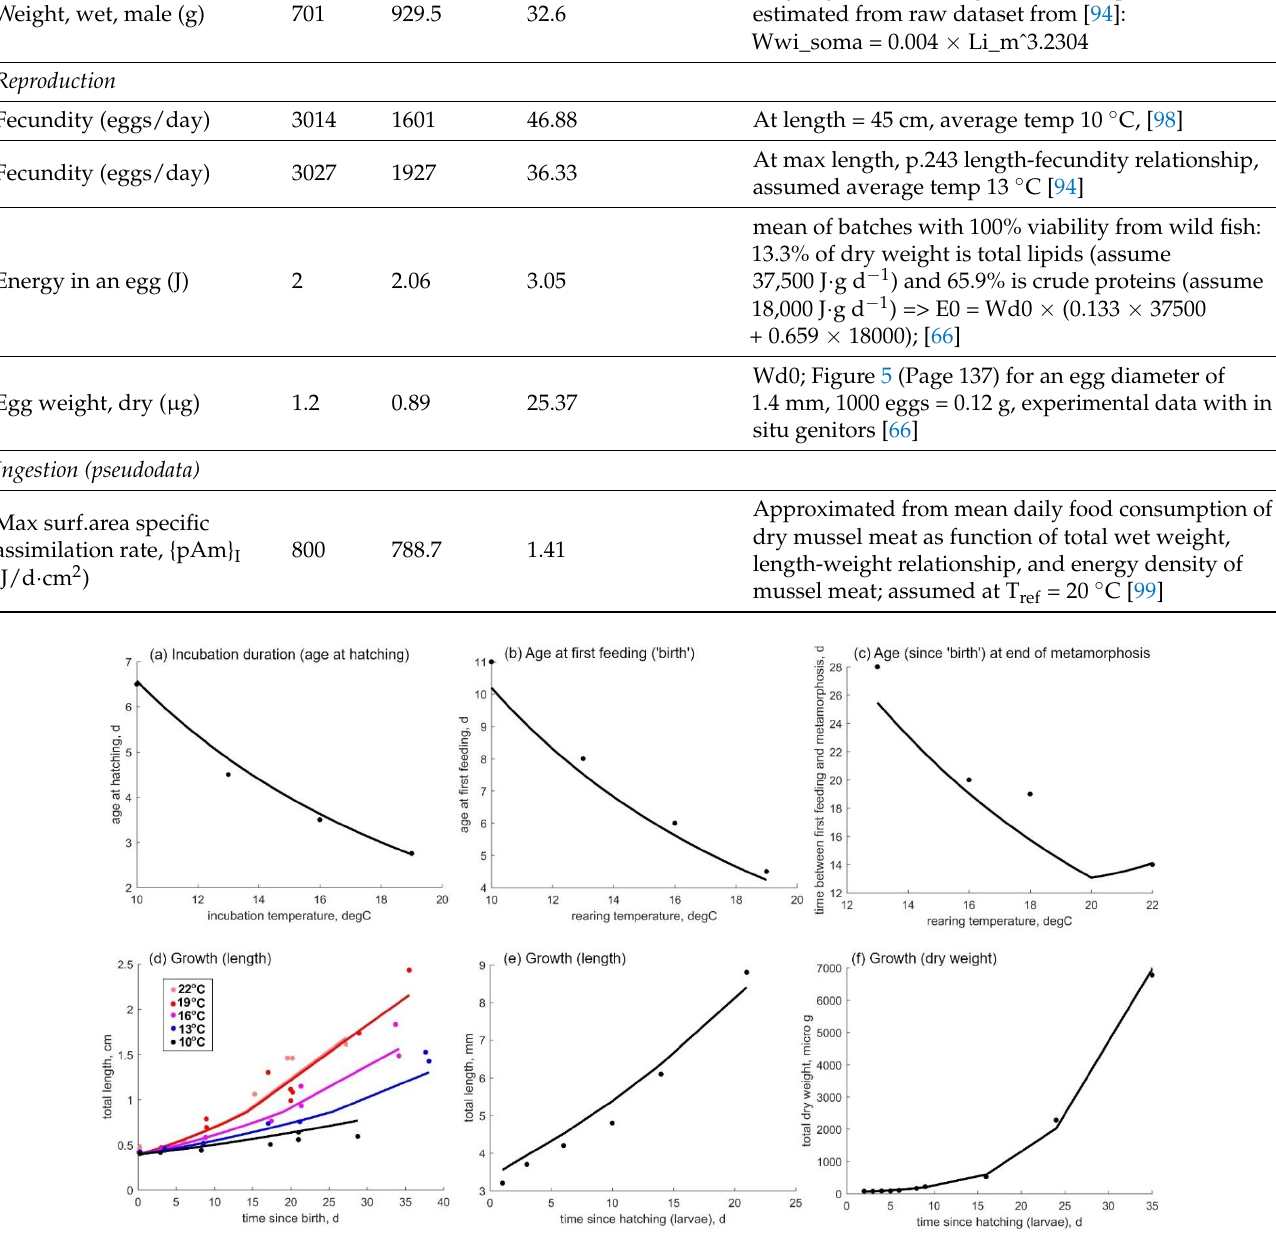
Figure A1. Larval development and growth of S. solea . ( a – c ): duration of developmental stages as a function of incubation or rearing temperature; ( d – f ): larval growth in total length and dry weight over time. Data sources and corresponding conditions (estimated scaled functional response f , simulated temperature T): Panels a-d: [41]( f = 0.4451, T = 10, 13, 16, 19 °C for panels ( a , b ), T = 13, 16, 18, and 22 °C for panel ( c ), and T = 10, 13, 16, 19, 22 °C for panel ( d )); Panel ( e ): [100] ( f = 0.305, T = 11.2 °C for incubation (fertilization to hatching), 16.1 °C from hatching to birth, and 19.1 °C from birth onward; Panel ( f ): [40] — mean values ( f = 0.4813, T = 12 °C for incubation (fertilization to hatching), then T = 15 °C).